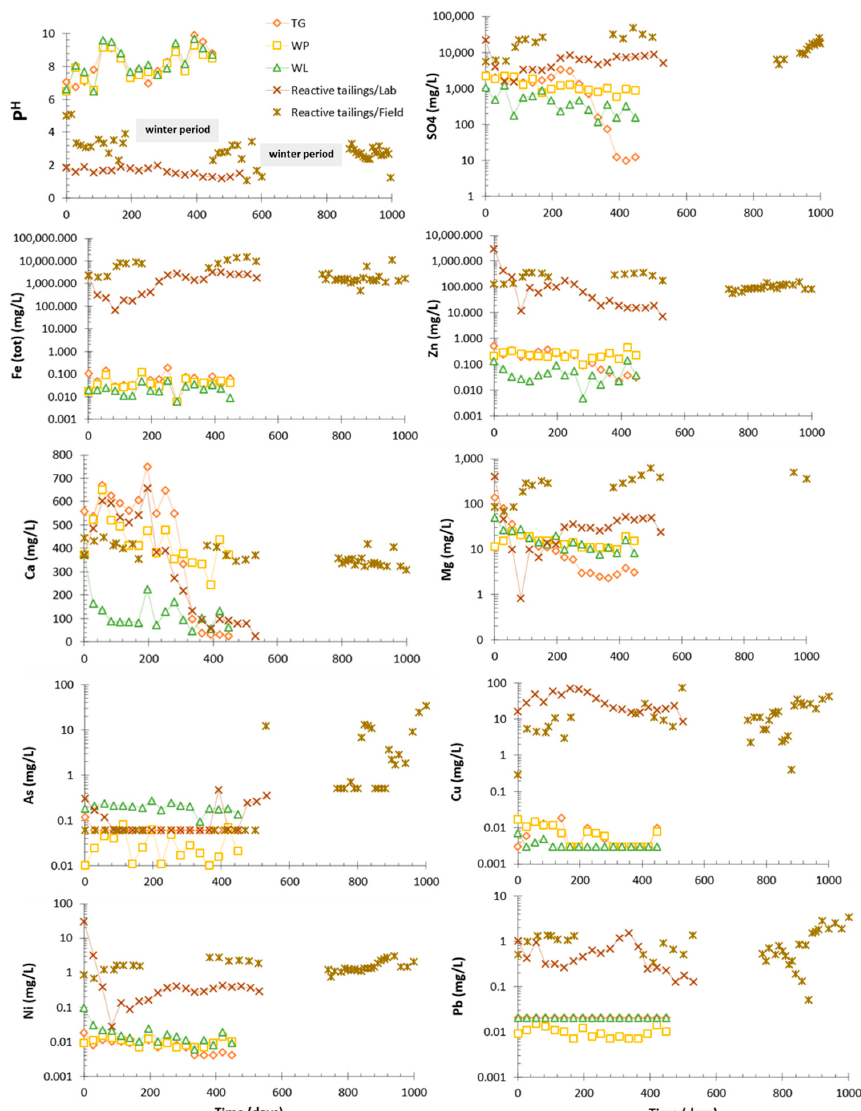
Figure 6. Water quality evolution in leachates from the reactive tailings and cover materials.